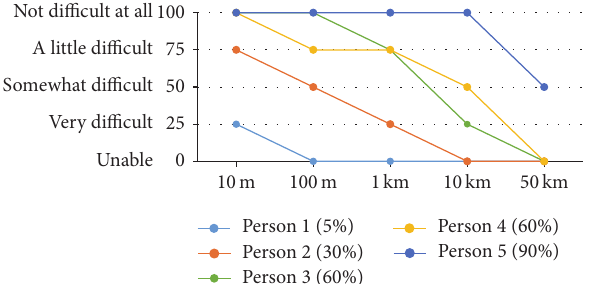
Figure 1: Examples of five individual ability curves: walking ability curves for 5 persons with summary scores ranging from 5% to